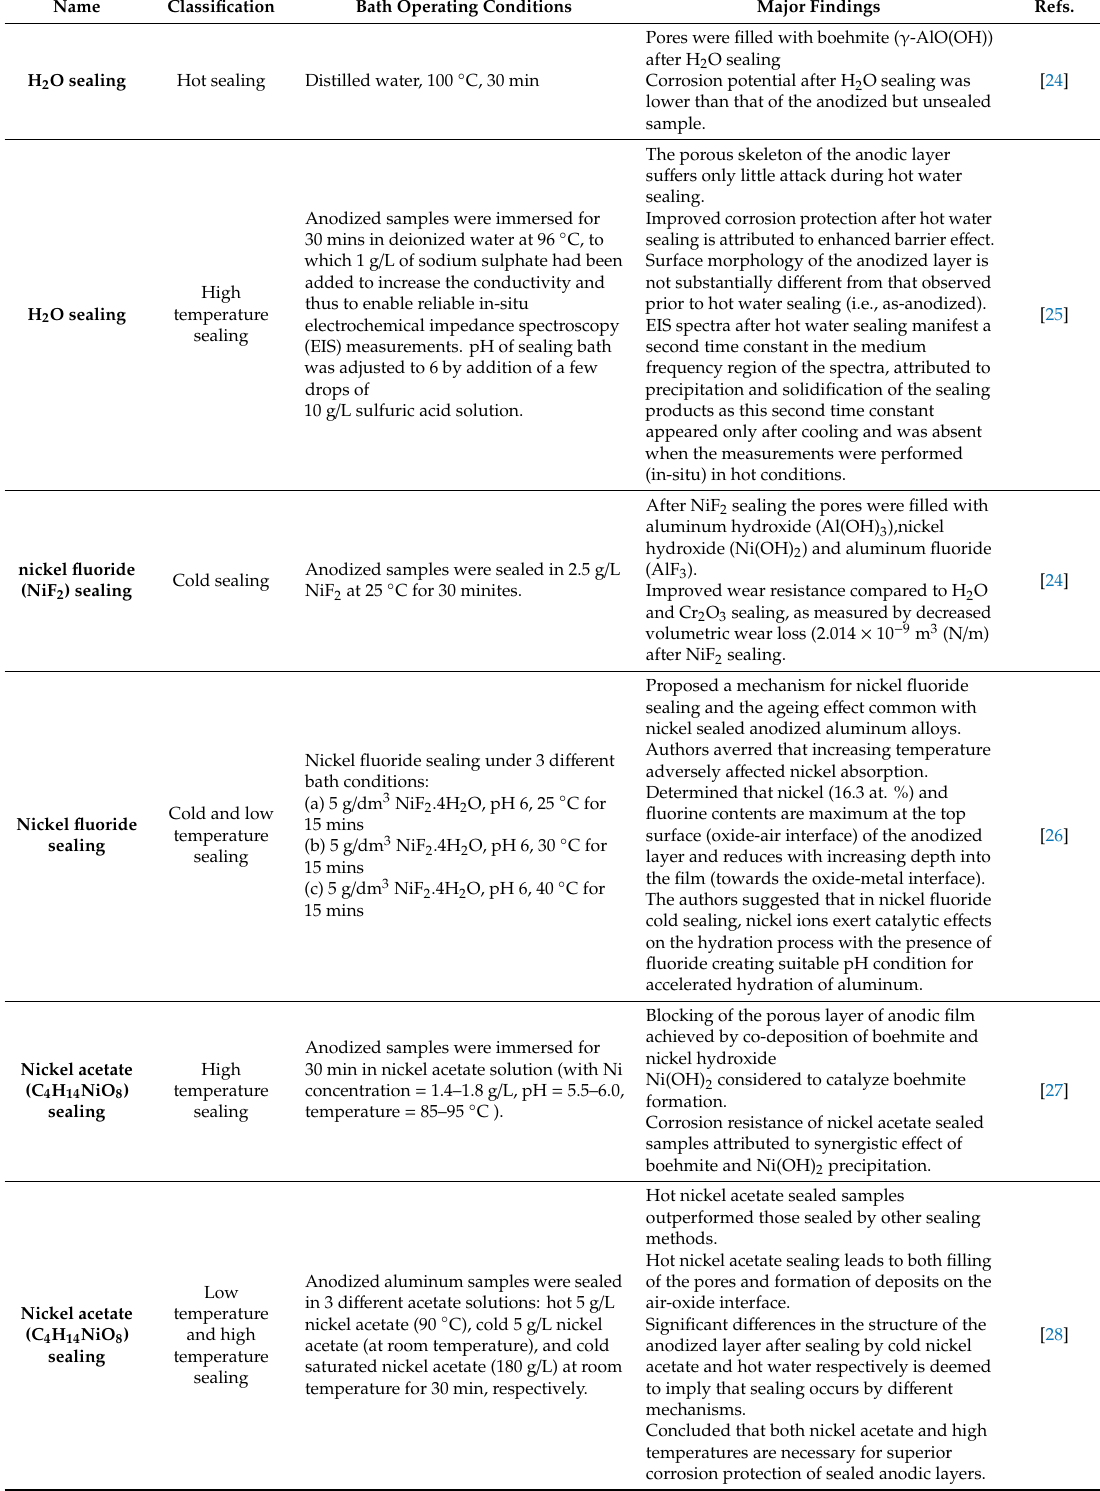
Table 1. Table of reported sealing procedures, sealing bath conditions and major